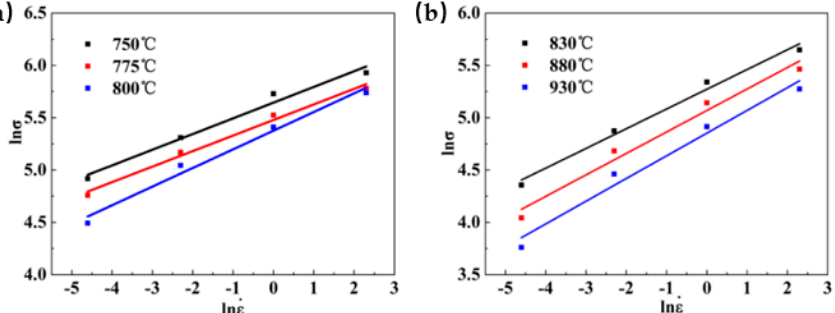
Figure 3. Relationship between ln σ and ln έ at different deformation temperatures: ( a ) α + β region; ( b ) β region.